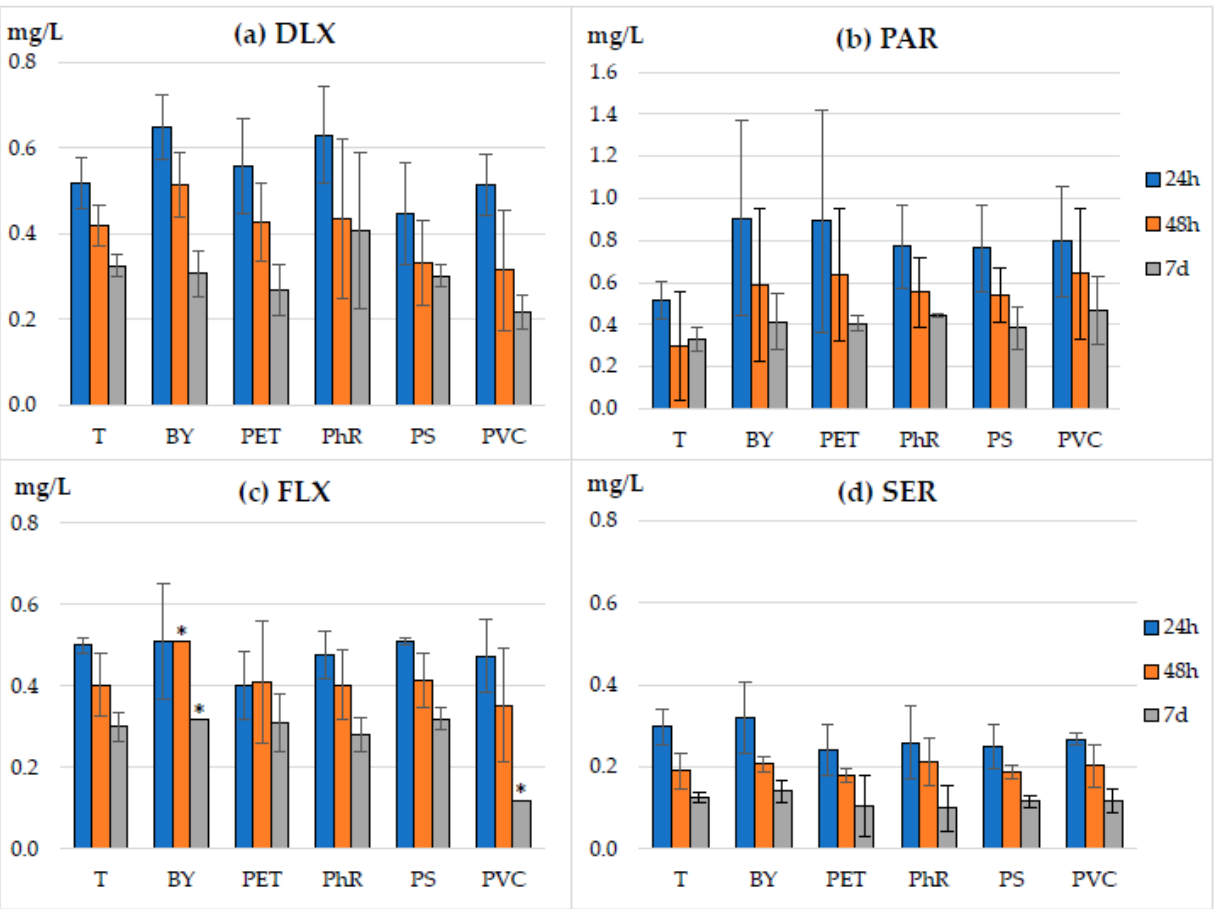
Figure 4. Acute toxicity data in the Spirotox test (EC 20 ) of the tested pharmaceuticals with and without microparticles, ( a ) duloxetine; ( b ) paroxetine; ( c ) fluoxetine; and ( d ) sertraline. T—Tyrode’s medium, BY—baker’s yeast, PhR—phenolic resin, PVC—polyvinyl chloride, PET—ethyl polyterephthalate, PS—polystyrene, *—the toxic effect in the control and the lowest concentration higher than